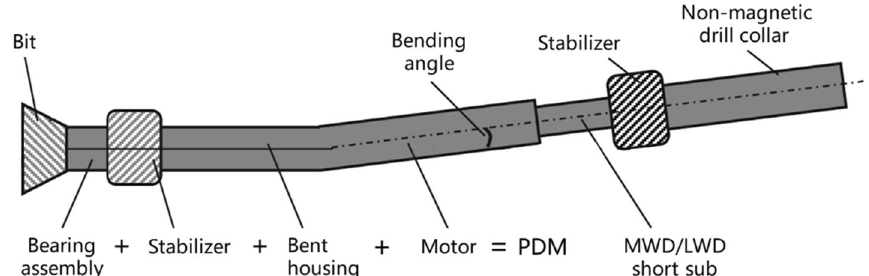
Fig. 17 Schematic of drill tool assembly with the single bent housing PDM